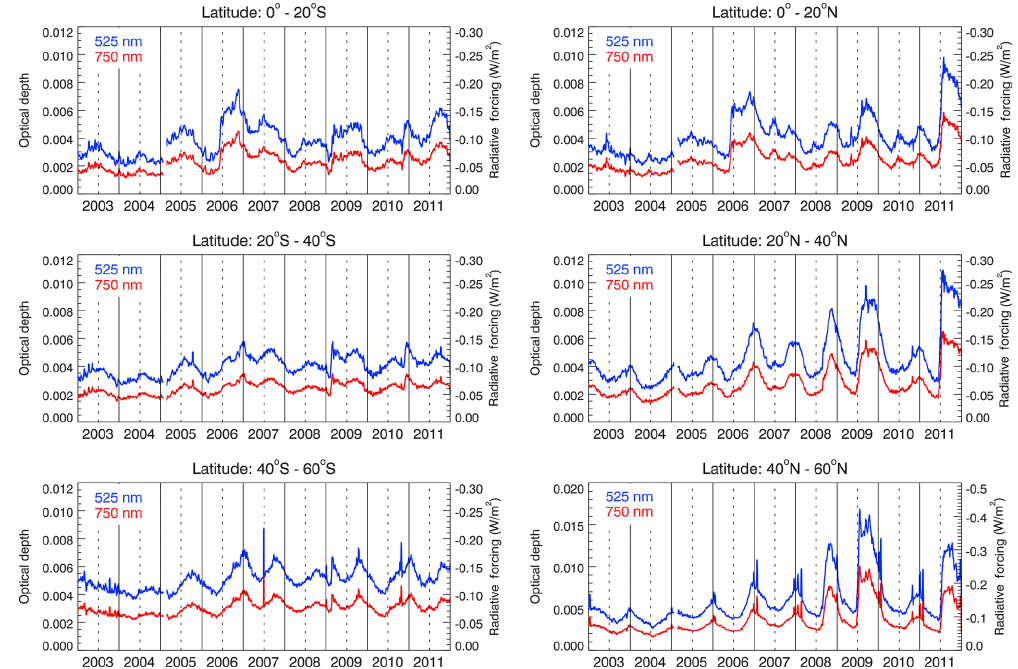
Figure 8. Stratospheric aerosol optical depth (between 380K potential temperature and 40km altitude) time series at 525 and 750nm wavelength for different 20 ◦ latitude bins. Note that the right ordinate only applies to the blue line, i.e., 525nm